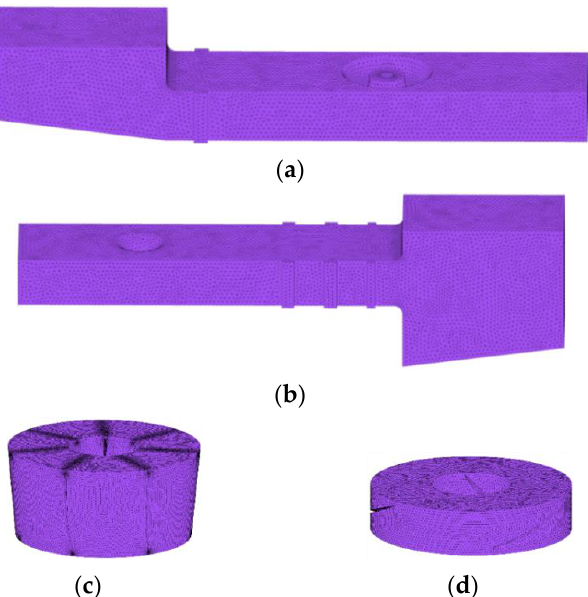
Figure 4. Schematic diagram of grid division of the pump device: ( a ) inlet channel; ( b ) outlet channel; ( c ) guide vane; ( d ) impeller.